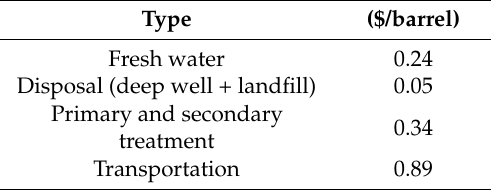
Table 3. Cost of transportation, fresh water, treatment and disposal of